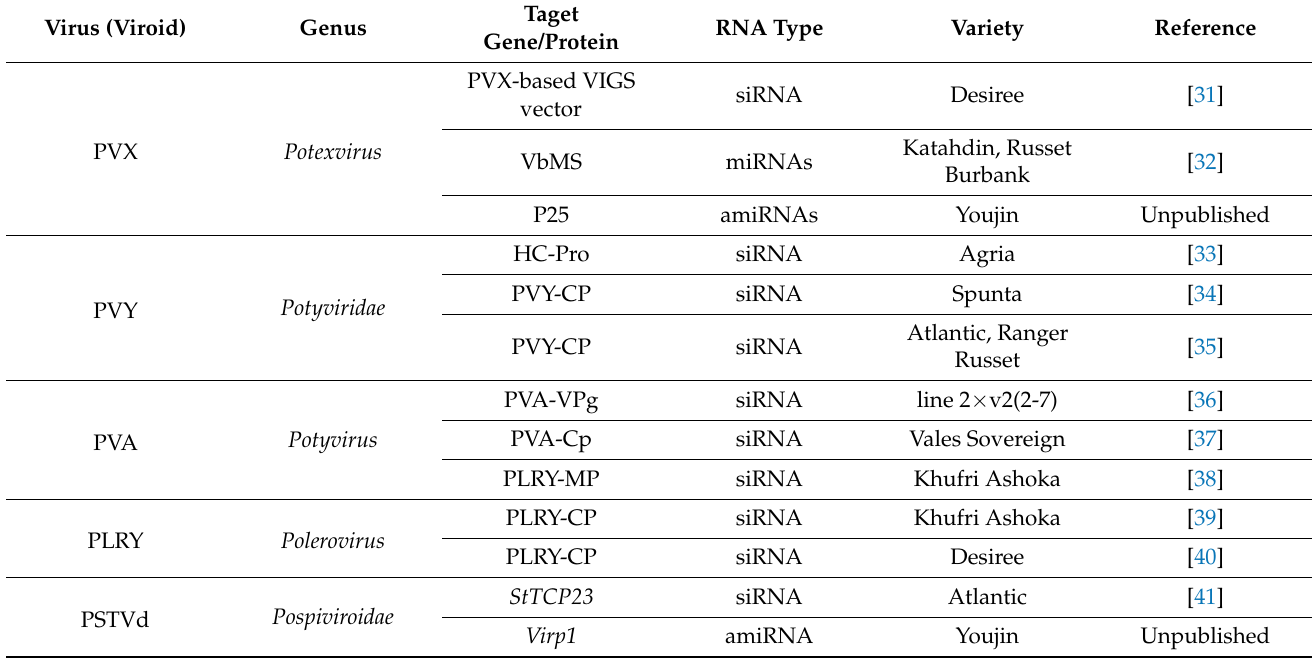
Table 1. Summary of the application of RNA silencing to the viral pathogens of